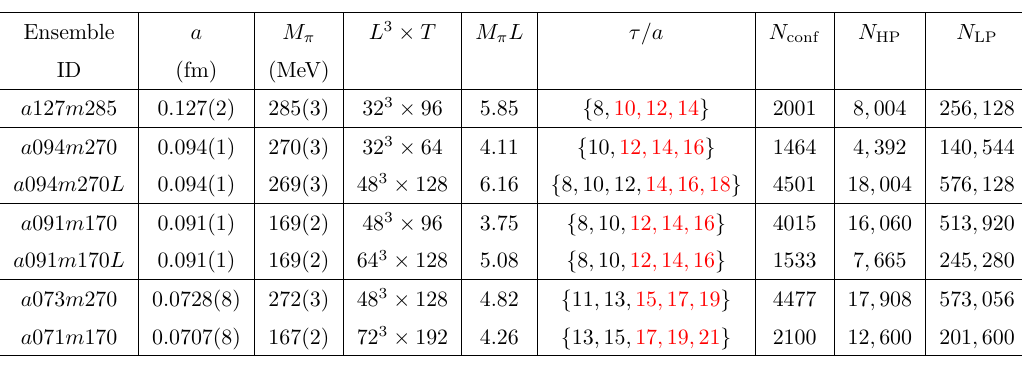
Table 1 . Lattice parameters of the 2+1-flavor clover ensembles generated by the JLab/W&M/ LANL/MIT collaborations and analyzed in this study. We give the lattice spacing a , pion mass M π , lattice size L 3 × T , the values of source-sink separation τ simulated, the number of configurations analyzed, and the total number of high precision (HP) and low precision (LP) measurements made. The values of τ in red are used in the fits to remove